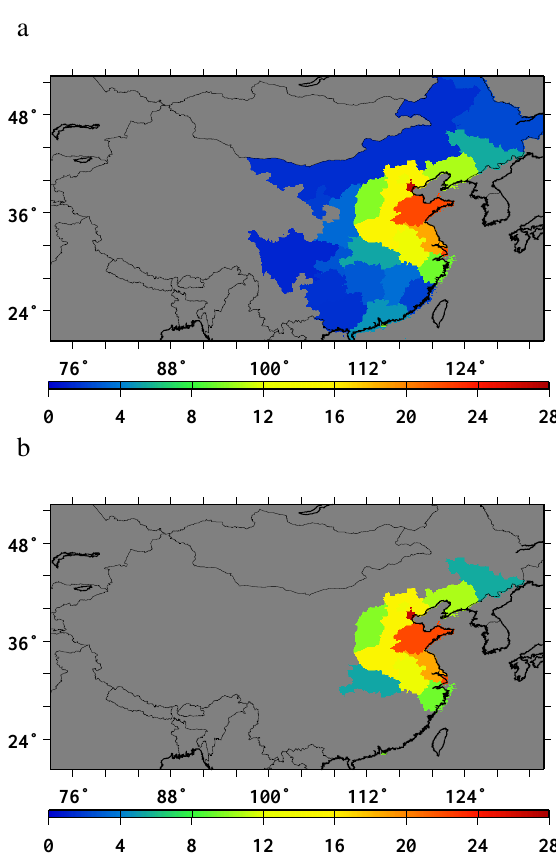
Fig. 2. Multiannual evolution of the CO 2 and NO x anthropogenic emissions in China and the behavior of the corresponding NO x - to- CO 2 emission conversion factor F (see Eq. 8) according to the EDGAR v4.2 and REAS (v1.11 and v2.1) emission invento- Fig. 3. The provinces of China taken into account in the analysis of ries. The emissions are normalized to their values in 1996. Note Fig. 3. The provinces of China taken into account in the analysis of the spatial distribution of emission changes for different threshold that the version 1.11 of the REAS inventory was used for the first levels, [NO 2 ] c , of the (depicted in the plots) annual mean measured (1996-2001) period analyzed in this study, because the REAS v2.1 tropospheric NO 2 column amounts for year 2008: (a) [NO 2 ] c = 1 × inventory was not available for this period. 10 15 moleculescm − 2 , and (b) [NO 2 ] c = 5 × 10 15 moleculescm − 2 .